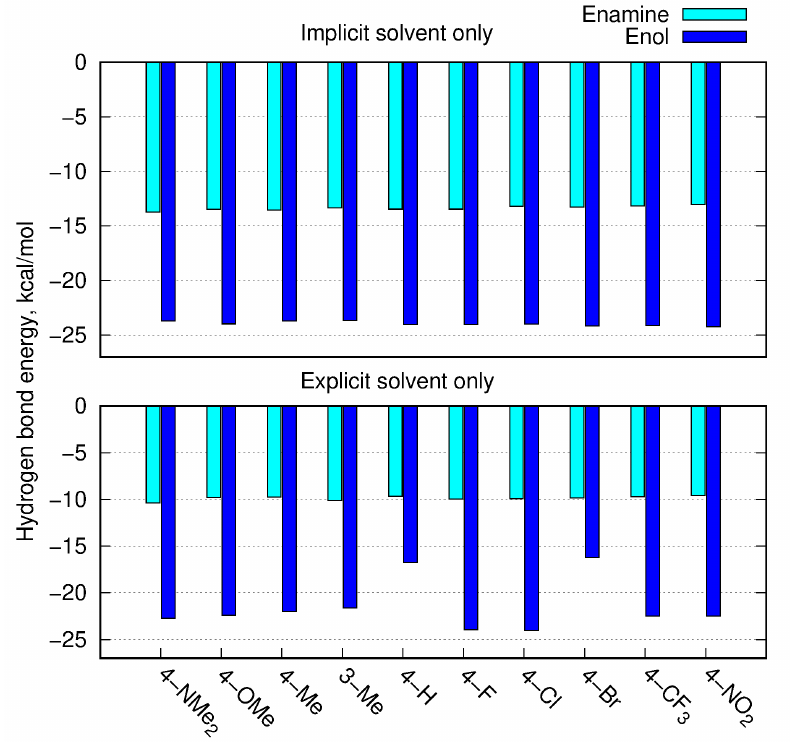
Figure 7. Estimation of intramolecular hydrogen bond energy (kcal/mol) in enamine and enol forms estimated according to Espinosa [28], for the ω B97X-D/def2-TZVP approach in the PCM solvent model (upper panel) and with the explicit solvent (lower